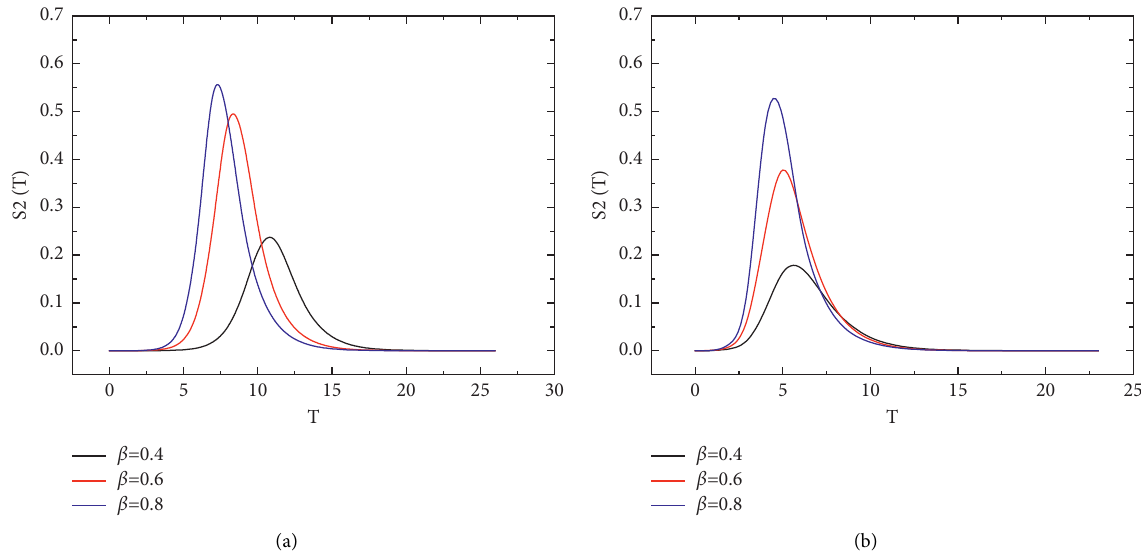
Figure 5: Density of spreader 2 over time for different values of β . (a) WS small-world network. (b) BA scale-free network.